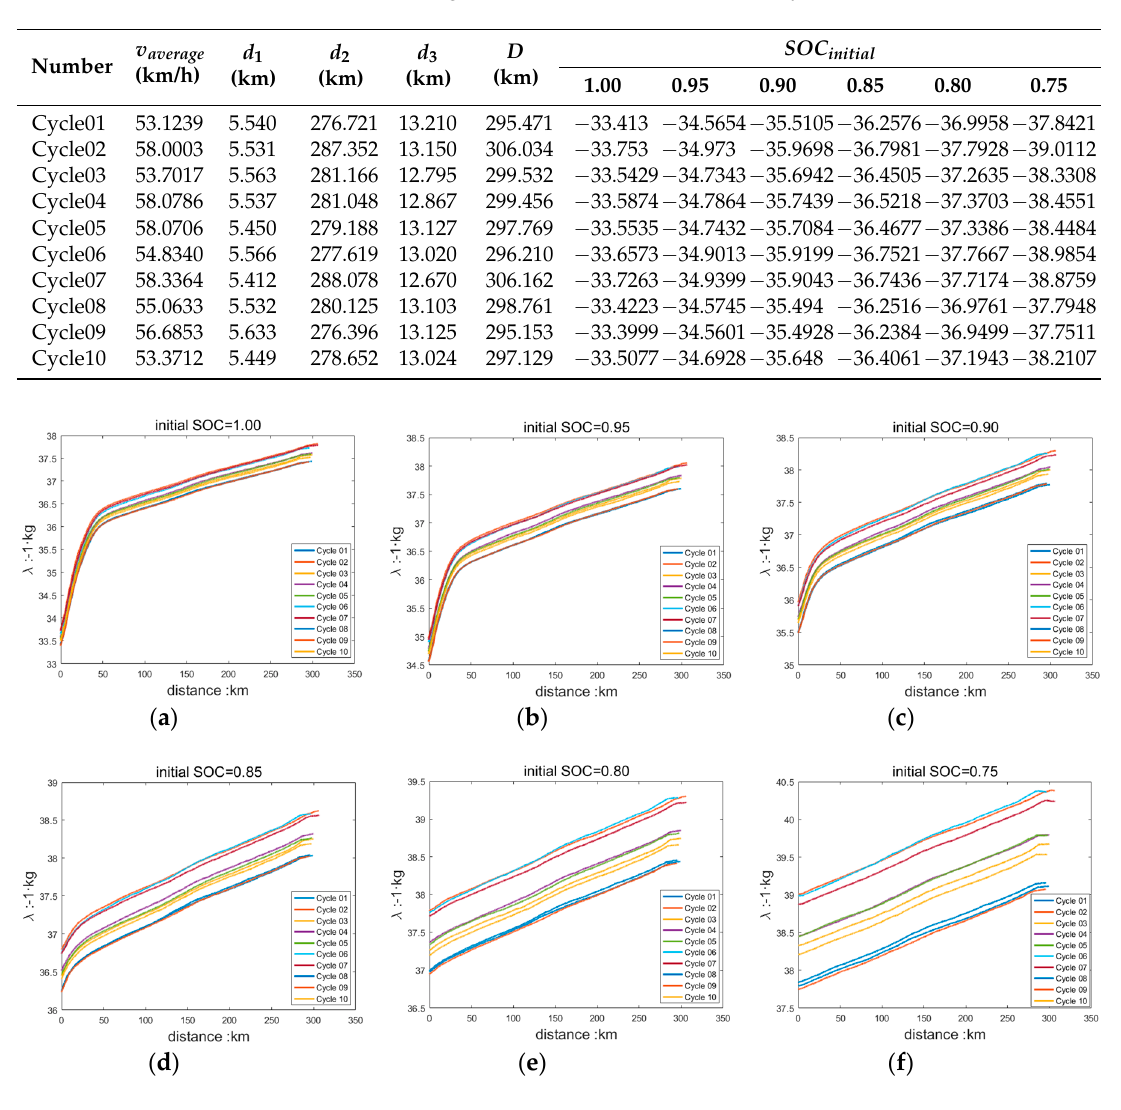
Figure 13. The change curve of λ when λ 0 is taken.